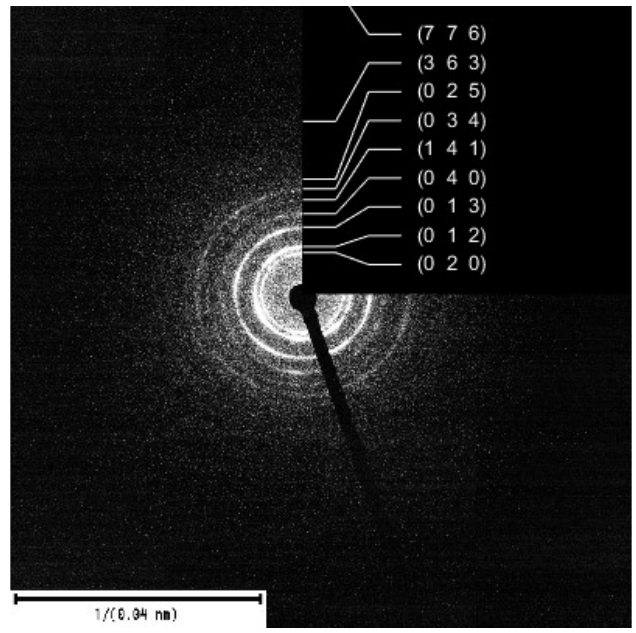
Figure 11. Selected area diffraction (SAED) surface sublayers, phase indexed Ti 3 Al. The layer was further examined using electron energy loss spectroscopy (EELS). The Ti-L 2,3 , N-K, and C-K spectra for TiAlN and TiAlCN coatings exhibited peak shapes and positions similar to those of TiC and TiN [58,59]. The presence of C was detected in a very small amount in the sublayer adjacent to the alloy, see Figure 12.